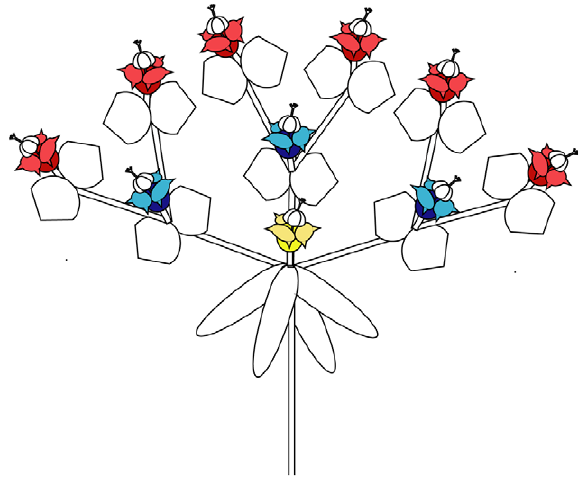
Figure 1. Diagrammatic representation of the inflorescences of E.boetica and E.nicaeensis showing the flowering order of the cyathia (levels), and the cyathia used for the intraindividual synchrony studies. Cyathia from different inflorescence levels are represented in different colors. First inflorescence level, yellow cyathium; second inflorescence level, blue cyathia; third inflorescence level, red cyathia. For simplification, we only show three inflorescence levels, but several inflorescence levels can be developed. Similarly, in the first branching (first inflorescence level) up to ten cyathia can spring from the terminal cyathium. In the following branching (second inflorescence level and higher) only two cyathia are bore from each terminal cyathium. In the study of flowering overlap among successive inflorescence levels, cyathia of different colors were compared. In the study of flowering overlap among cyathia of the same inflorescence level, cyathia of the same color were compared. Cyathia open